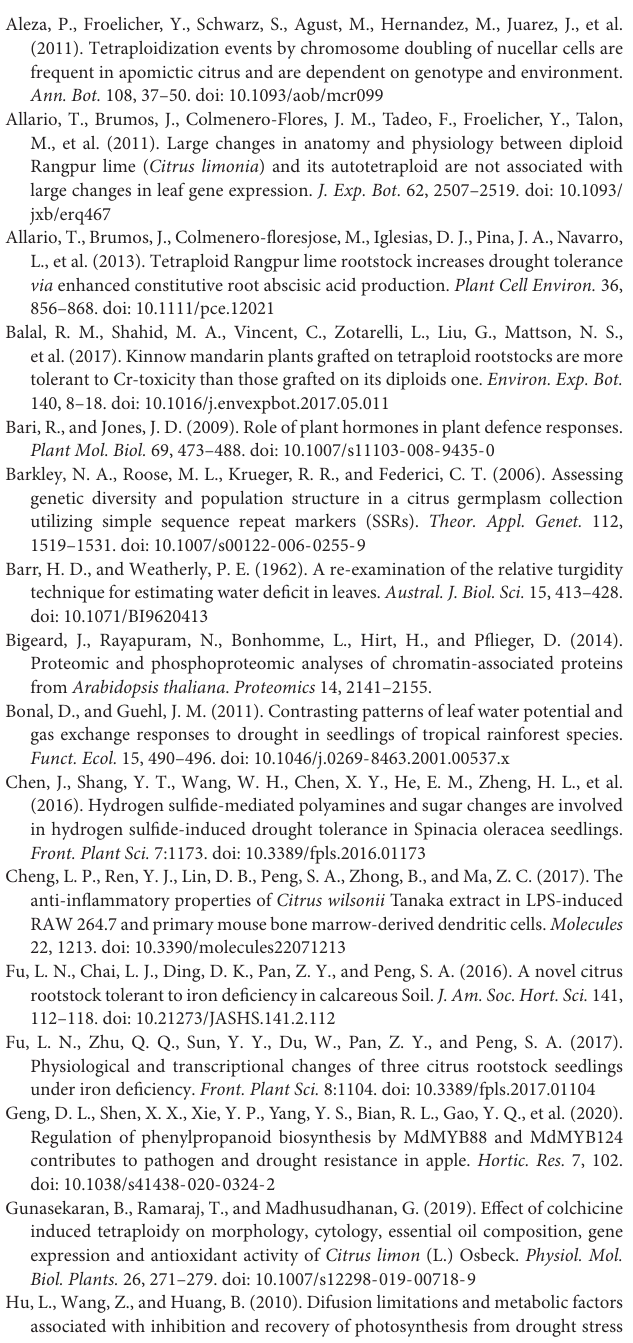
Supplementary Table 2 | Differential expression gene primer information of Citrus wilsonii by RT-qPCR analysis. Supplementary Table 3 | The detection calibration curves of each plant hormone sample for HPLC determination. Supplementary Table 4 | The data of quality control (QC) and relative standard deviation (RSD) of each plant hormone.